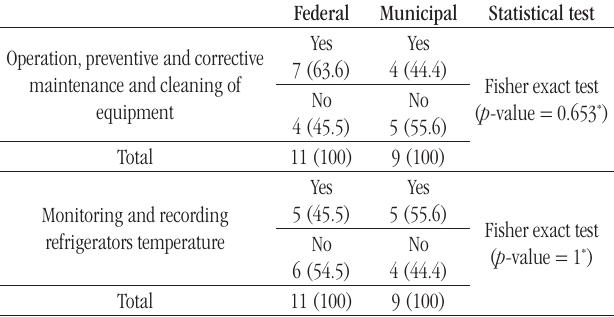
taBLE 5 − Operation, preventive and corrective maintenance, cleaning of equipment, refrigerators temperature monitoring